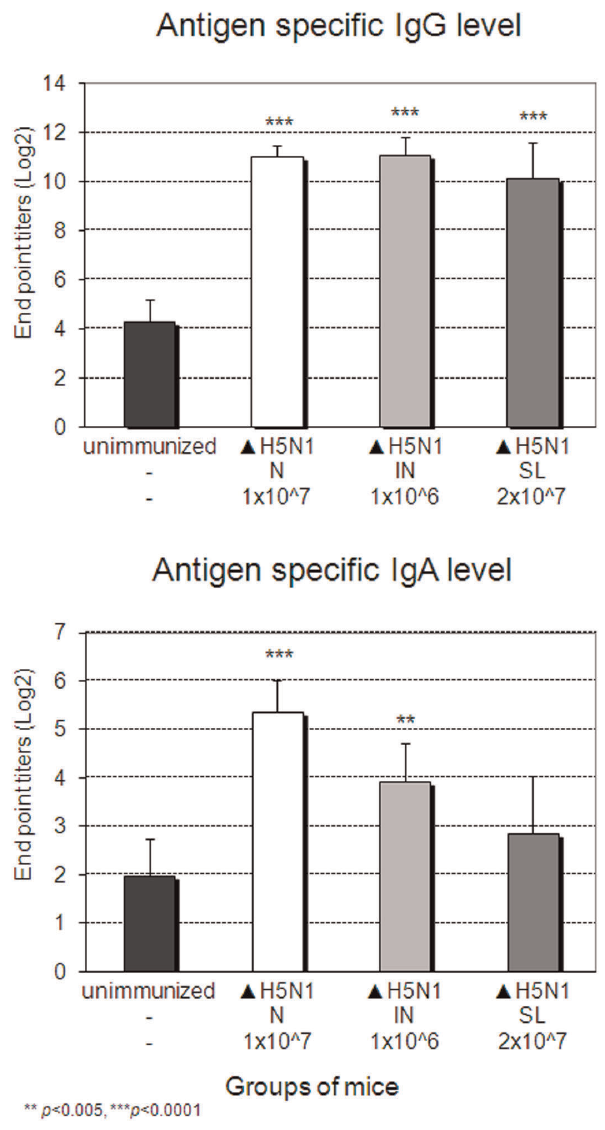
Figure 2. Induction of virus-specific IgG and IgA upon immunization with Delta H5N1. BALB/c mice were immunized with different doses of Delta H5N1 ( m H5N1) or wt live virus A/PR8/34 (PR8) H1N1 via the sublingual (SL), nasal (N) or intranasal (IN) route. Four weeks later sera were collected and the levels of H5N1 virus-specific IgG and IgA were determined by Delta H5N1 virus-coated ELISA plates. The values represent the mean + SEM (vertical bars) end point ELISA antibody titers determined on 5 mice per